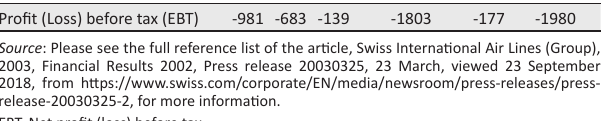
TABLE 9: Losses of SWISS International Air Lines. Variable